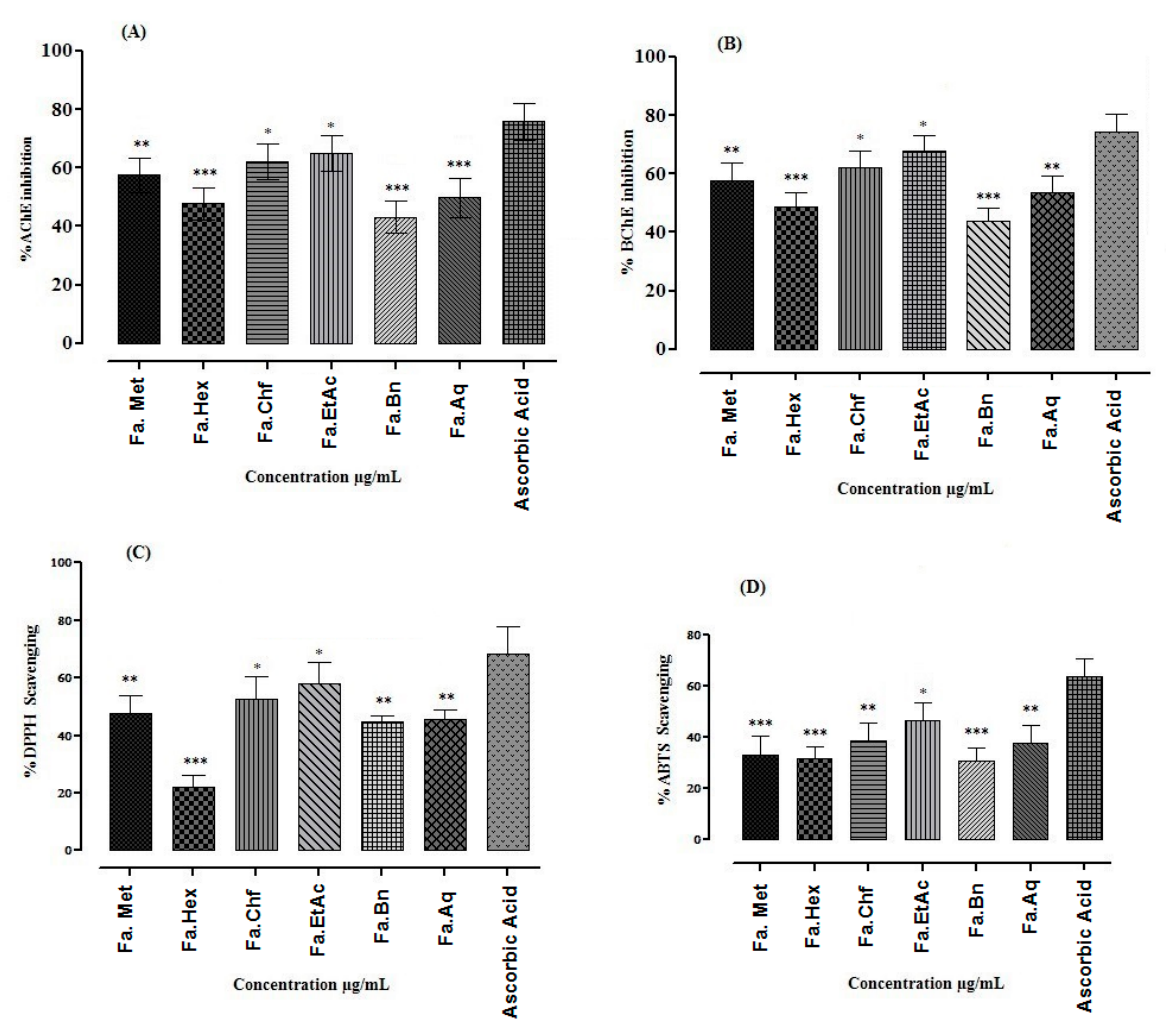
Figure 2. Percent anticholinesterase and antioxidant potential of extract/fractions of Ferula ammoniacum (D. Don) aerial parts. {( A ) Percent inhibition potential of extract/fractions for AChE and ( B ) BChE; ( C ) DPPH and ( D ) ABTS free radical. The data are expressed as Mean ± SEM, ( n = 3). One-way ANOVA followed by Dunnett’s post hoc multiple comparison test to determine the values of p . Values are significantly different as compare to positive control, * p < 0.05, ** p < 0.01, *** p < 0.001}.